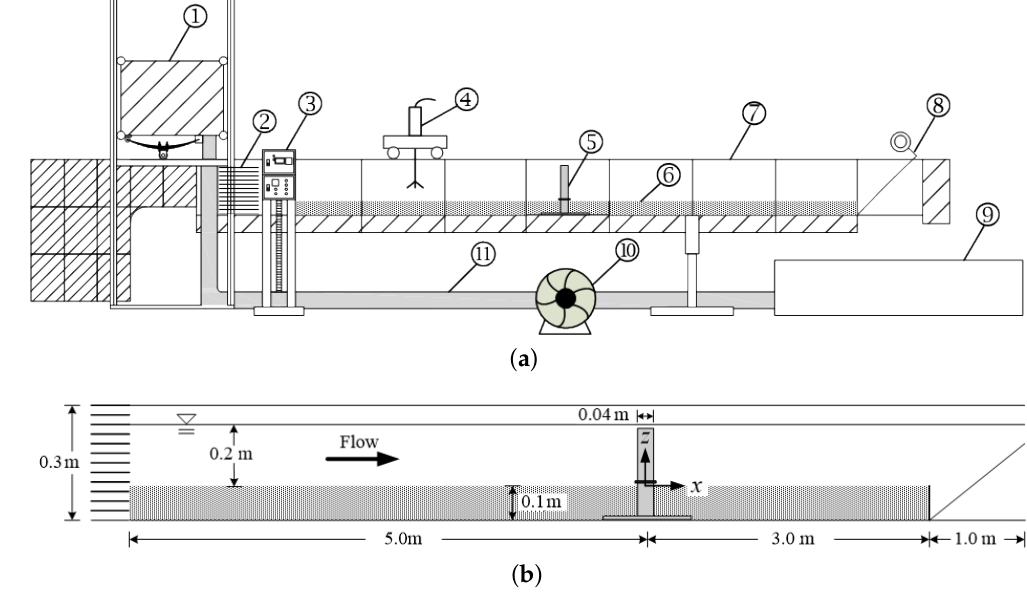
Figure 2. The flume system used for the experiments: ( a ) side view and ( b ) schematic diagram of the bridge pier and coordinate system. 1. Head tank. 2. Flow straightener. 3. Control